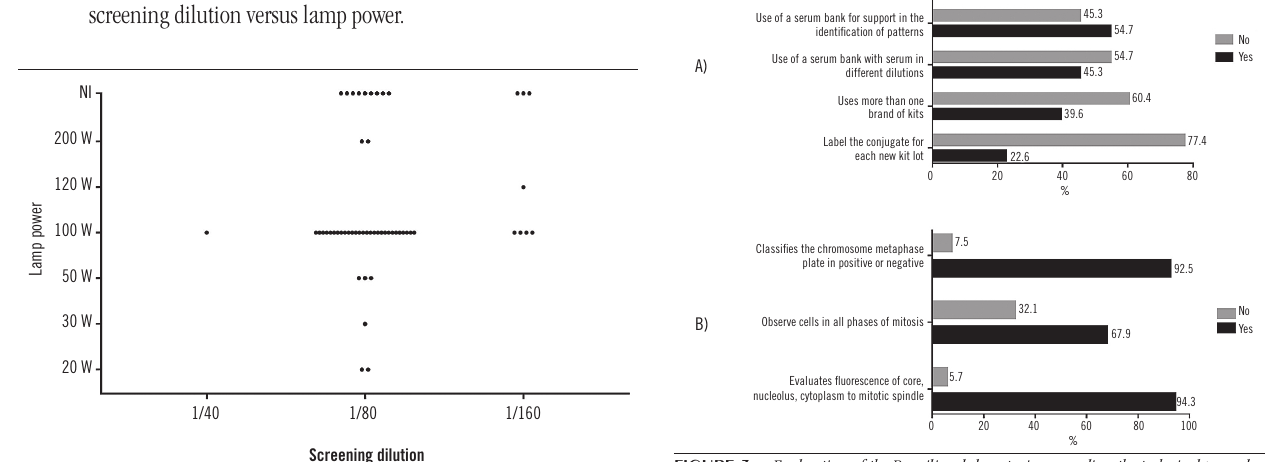
figurE 3 − Evaluation of the Brazilian laboratories regarding the technical procedures of quality control and strategy for slides reading A) laboratory responses in relation to the technical quality assurance procedures of the assay; B) laboratory responses regarding the technical procedures for slides